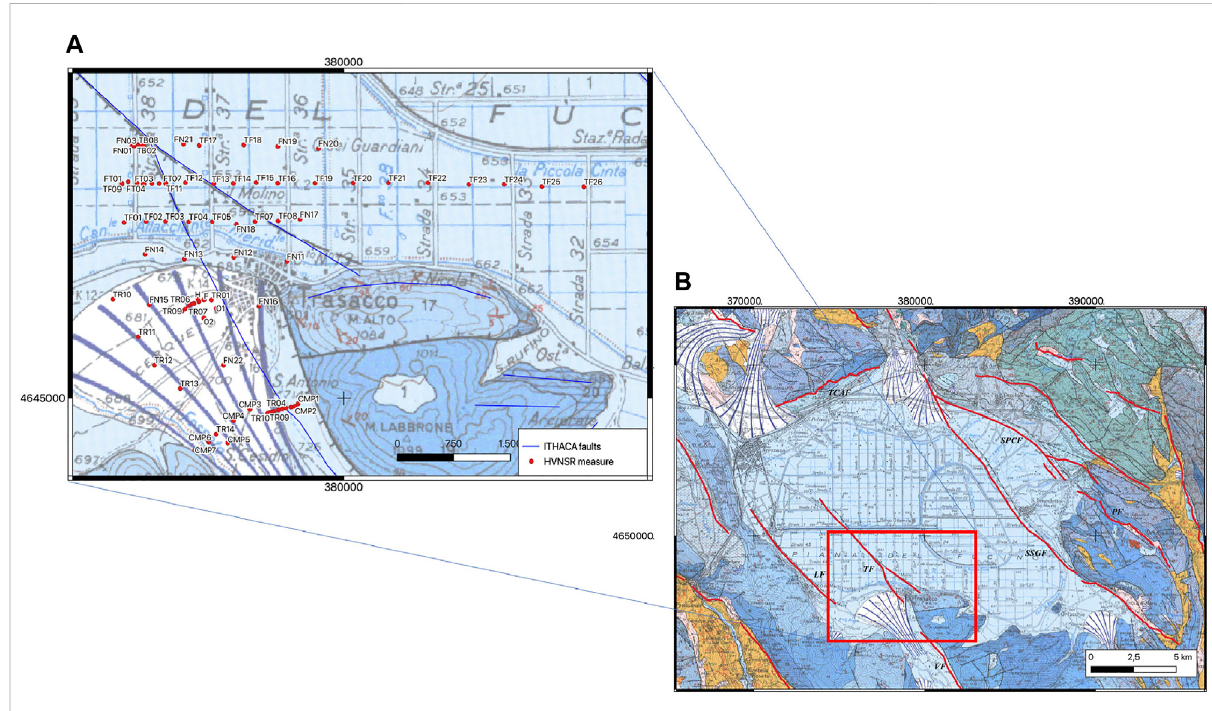
FIGURE 1 Geological map of the Fucino Basin (from Ghisetti and Vezzani, 1998) with the schema of the main fault lines in red (B) . Zoom of the study area with red dots representing the HVNSR investigations and fault lines in blue from the ITHACA database (A)